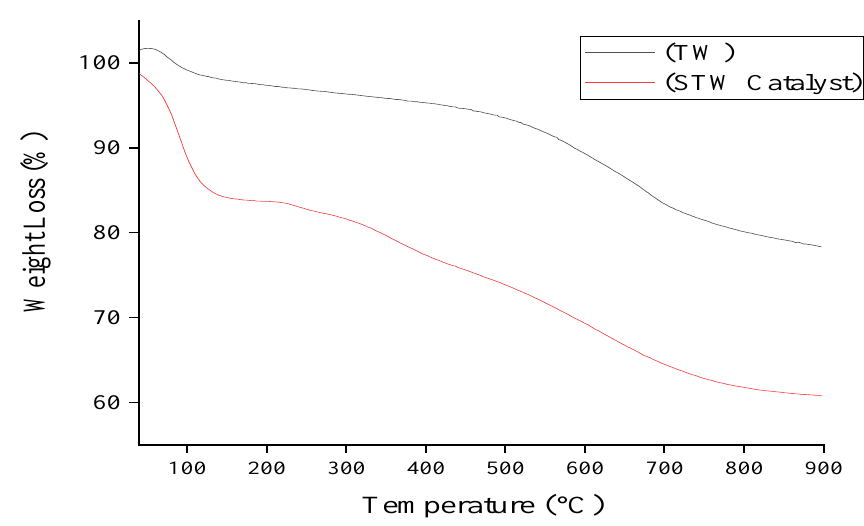
Figure 4. Thermograms of tea waste (TW) char and sulfonated tea waste (STW) acidic catalyst.